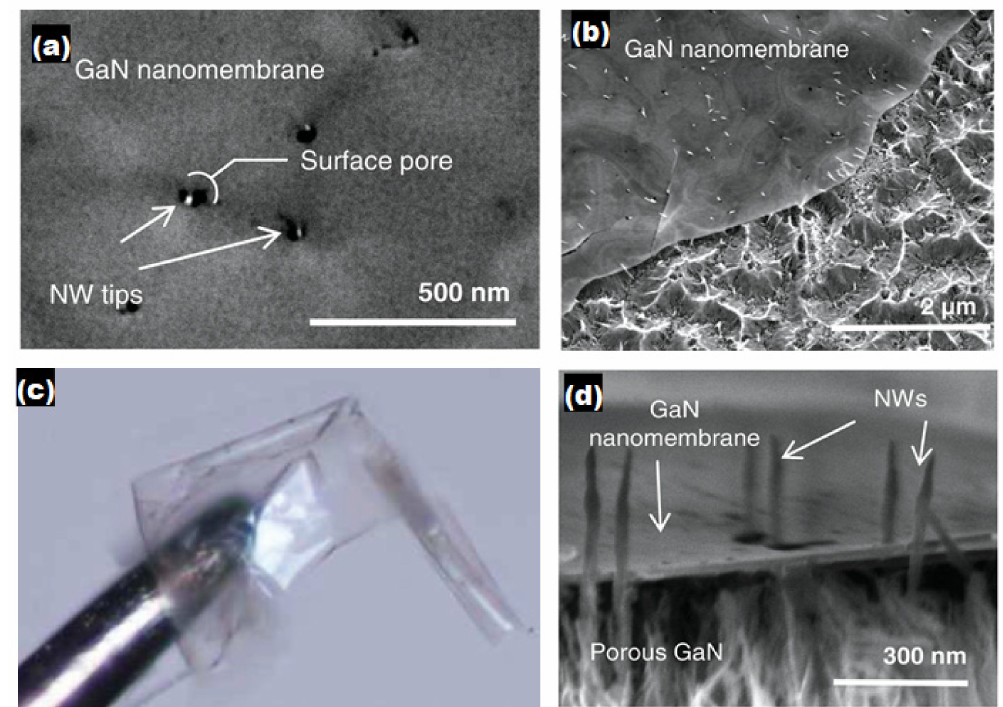
Figure 8. ( a ) SEM image showing the tips of the NWs below the surface pores. ( b ) Inclined top–view SEM image of the nanomembrane on top of the porous GaN. ( c ) The exfoliated GaN nanomembrane held at the tip of a tungsten probe. ( d ) Inclined cross-sectional SEM image of NWs protruding through the surface pores in the GaN nanomembrane. Reproduced from [98], with permission from Copyright WILEY-VCH Verlag GmbH & Co. KGaA,